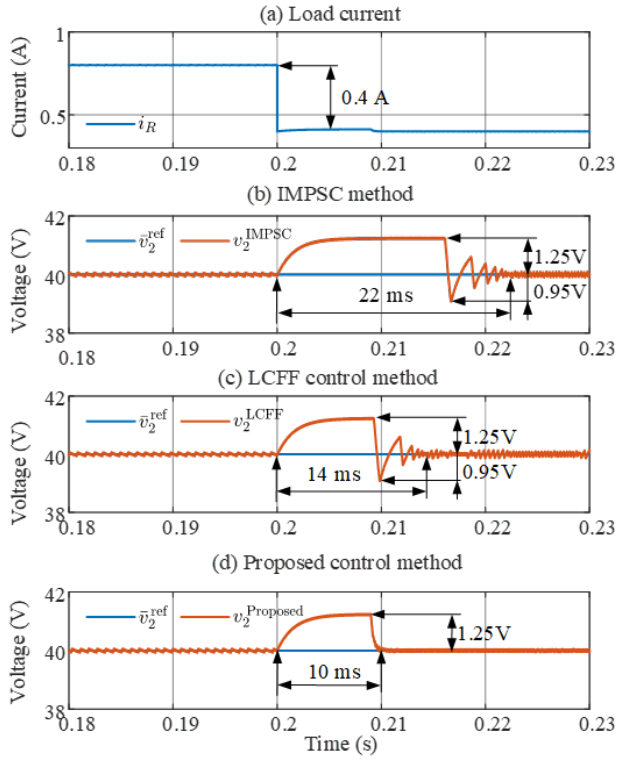
Figure 7. Simulation results of the output voltage when load steps up from 50 Ω to 100 Ω